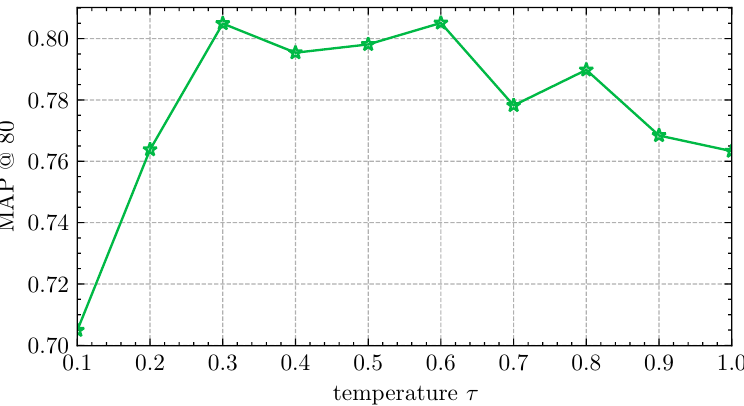
Figure 10. Model performance with various temperatures τ at 48 bits on UCMD.